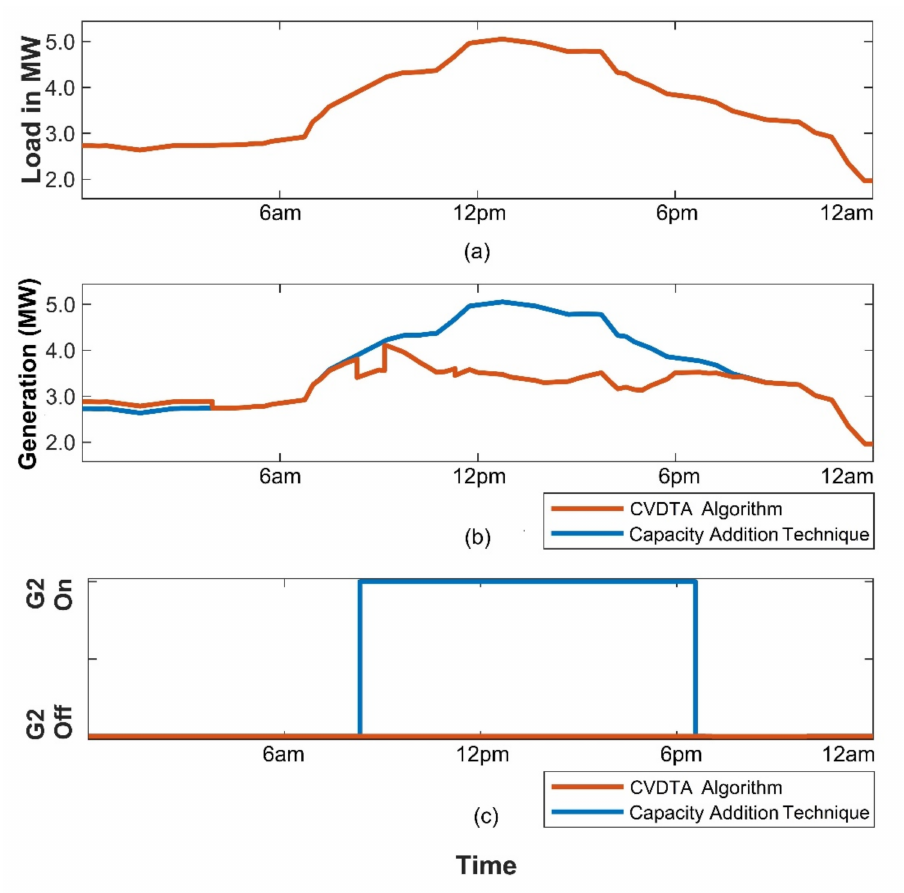
Figure 9. Comparative analysis between the CVDTA algorithm and the general capacity addition technique: ( a ) Variable load profile (semester break), ( b ) Operation of peak shaving, and ( c ) Operation of economic generation